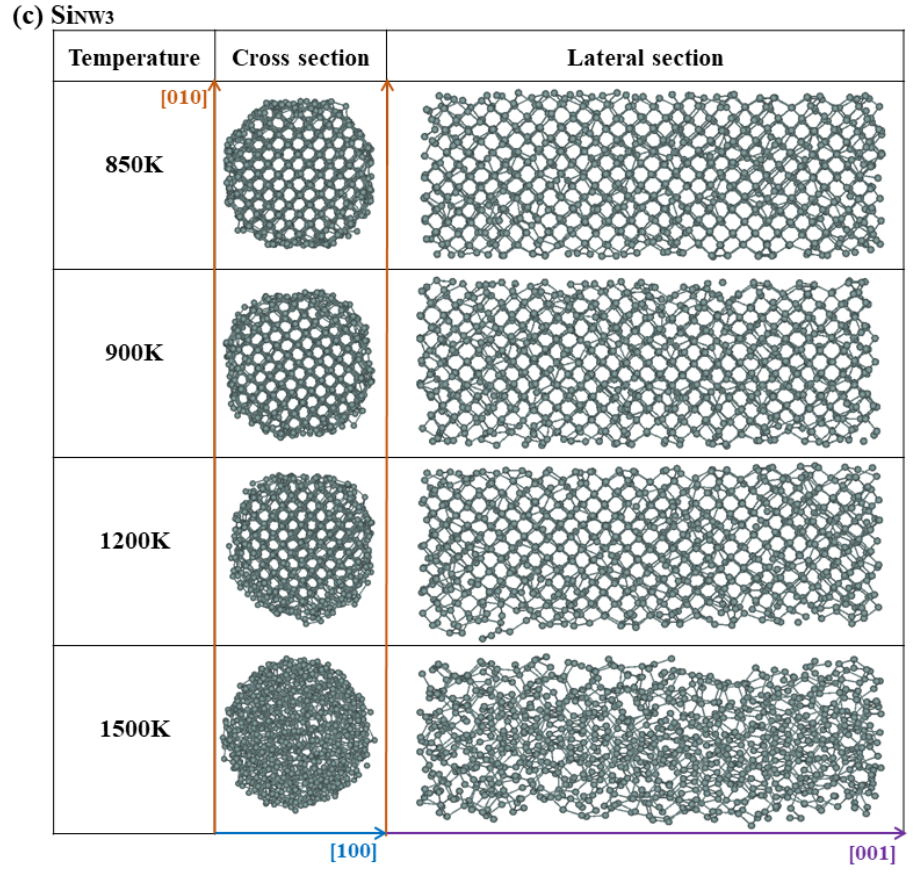
Figure 6. The atomic packing structures at different temperatures: ( a ) SiNW1, ( b ) SiNW2, ( c )